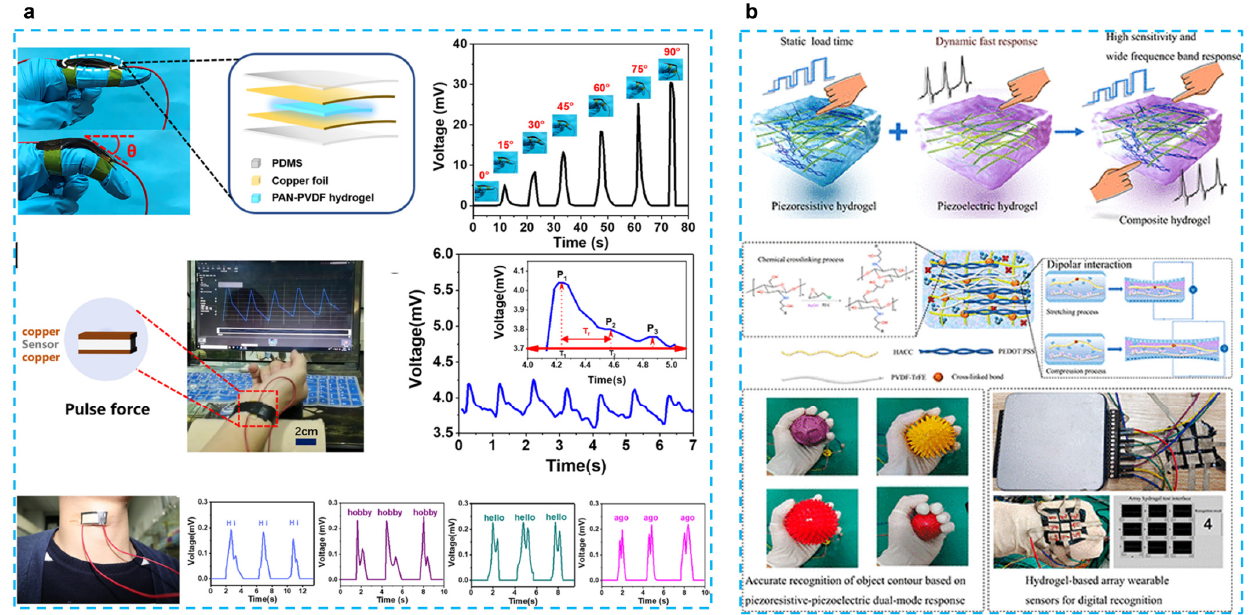
Figure 2. ( a ) A tough and self-powered hydrogel for artificial skin. (Reprinted with permission from Ref. [40], Copyright 2019, American Chemical Society.) ( b ) Enhancing strain-sensing properties of the conductive hydrogel by introducing PVDF-TrFE. (Reprinted with permission from Ref. [39], Copyright 2022, American Chemical Society.) Table 1. Hydrogel-based piezoelectric devices for sensing applications, including critical parameters and